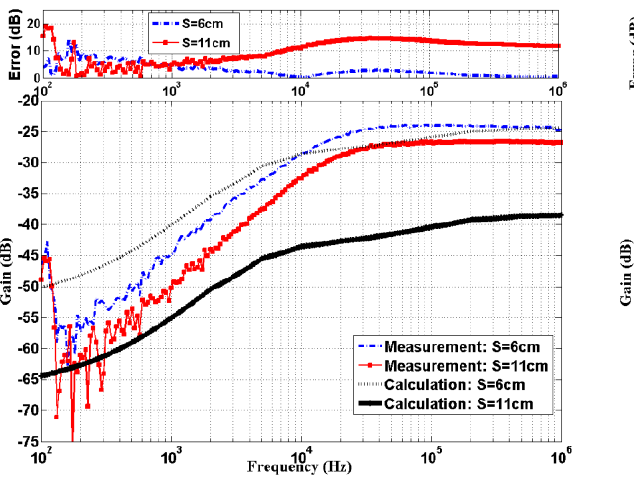
Figure 3. Calculated and measured transfer function characteristic of ( a ) Subject A; ( b ) Subject